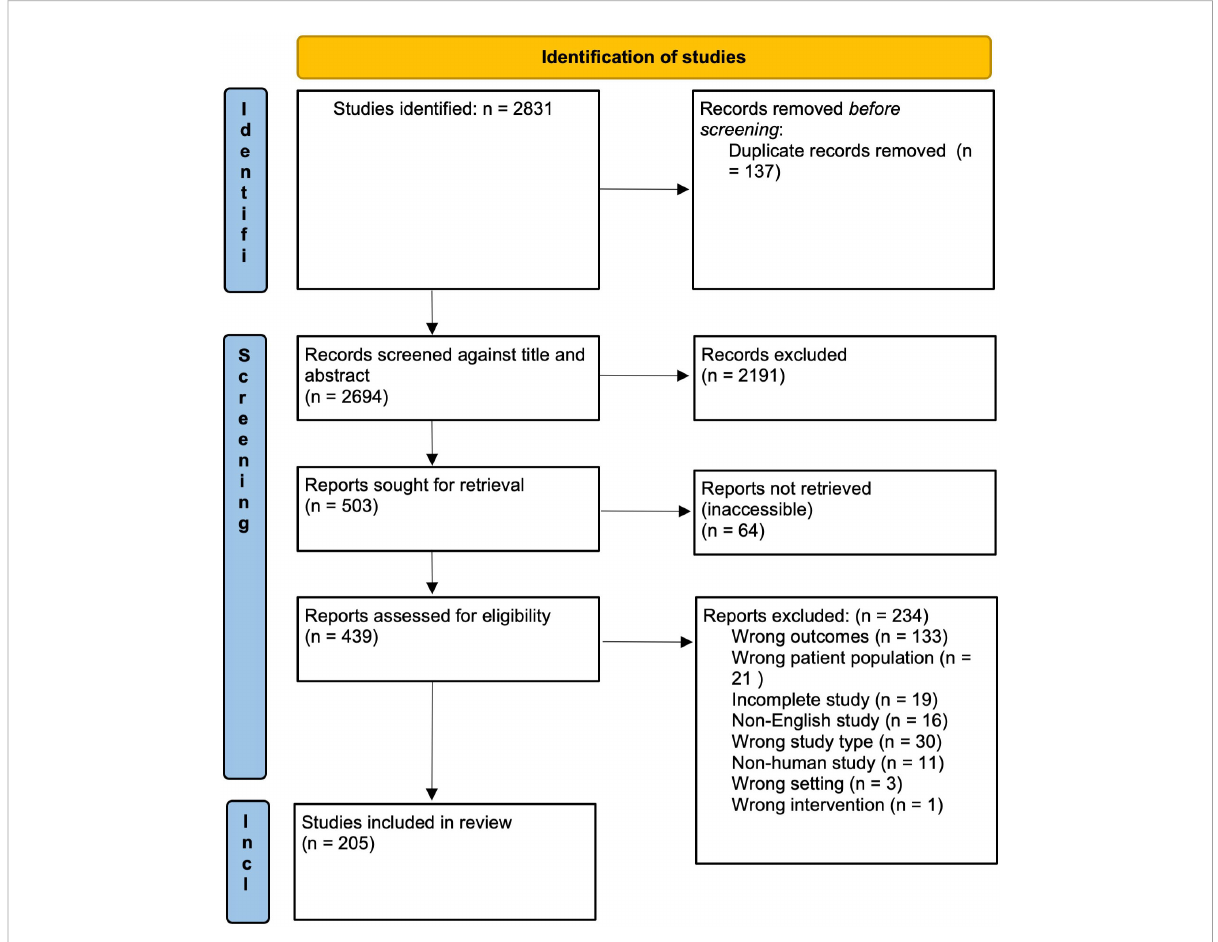
FIGURE 1 PRISMA fl ow diagram of study screening and selection. Adapted from The PRISMA 2020 statement: an updated guideline for reporting systematic reviews